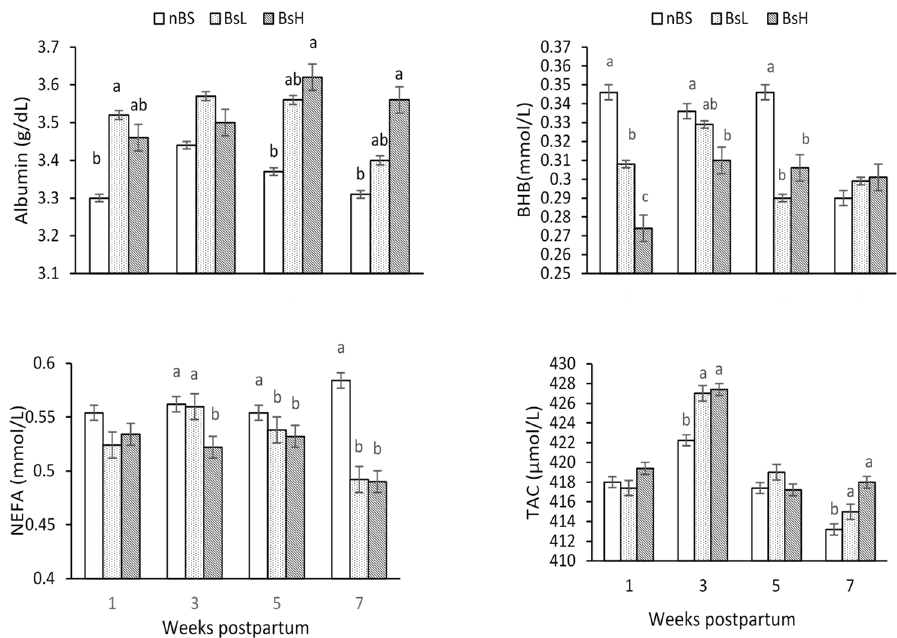
Figure 2. Treatment by time interaction ( means ± SEM) effects on blood plasma albumin concentrations, β - hydroxybutyrate (BHB), non-esterified fatty acids (NEFAs), and total antioxidant capacity (TAC) of transitioning goats that received 0 (nBS), 2 (BsL), and 4 (BsH) g of Boswellia sacra resin daily from week 2 prepartum to week 7 postpartum. Means within the same time period having different superscripts (a, b, c) differ significantly ( p < 0.05).